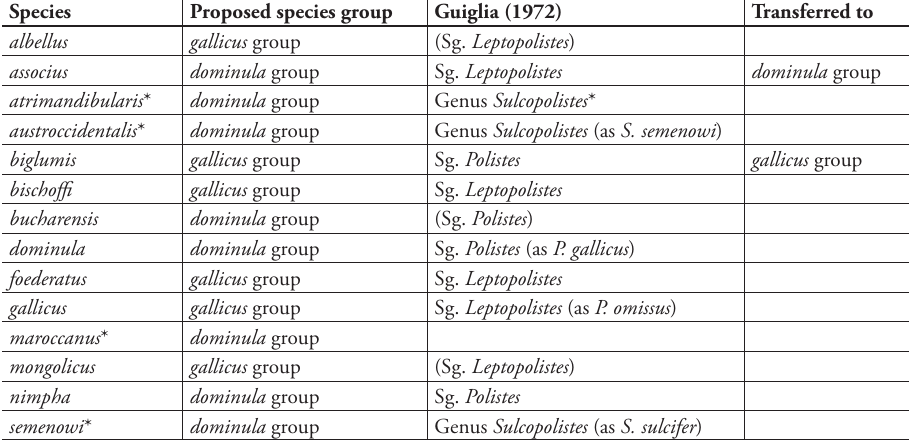
Table 3. Species and species groups of Polistes based on the present study and compared to Guiglia (1972). (Sg. = subgenus, * social parasite) Guiglia